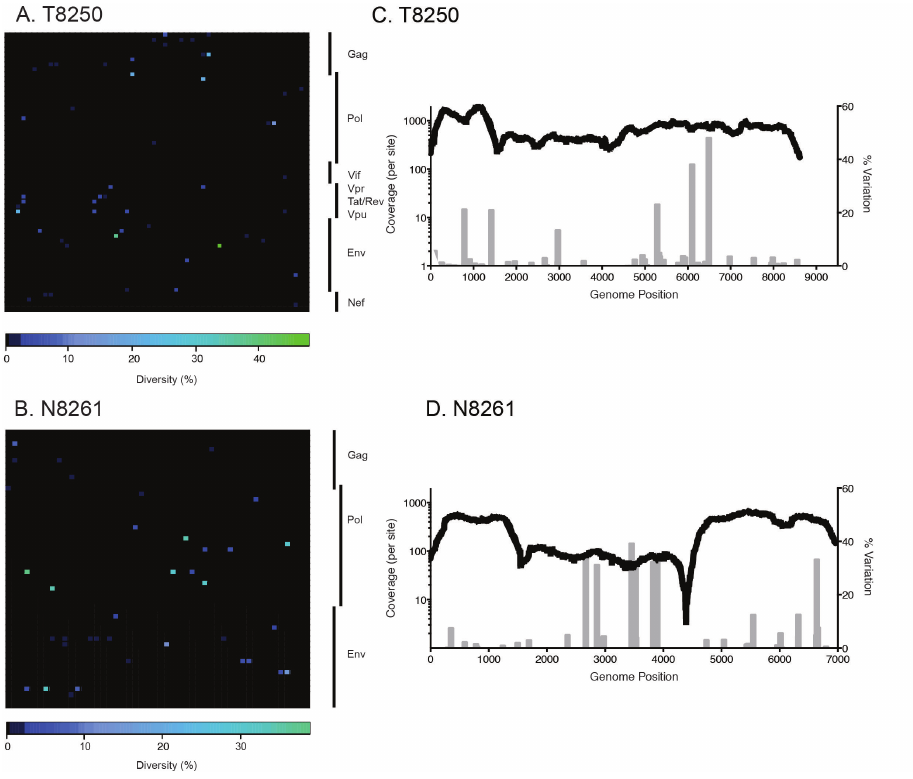
Figure 4. 454 deep sequencing of TF HIV-1 progeny in two subjects with acute infection. Heat maps illustrate both non-synonymous and synonymous codon sequence diversity of HIV-1 from DBS RNA in subjects T8250 (A) and N8261 (B). The plots are a graphical representation of the frequency of the intra-host sequence diversity with respect to the dominant codon residue (% diversity) for each codon (x-axis) of individual canonical HIV-1 proteins (y-axis). Each square represent a single codon, colored to reflect the percentage of reads that differ from the consensus residue. The diversity scale is color-coded with completely conserved residues in black and marine-blue tones for low-frequency polymorphisms in codons (< 10%), sky-blue tones for those with moderately high frequency (10–30%) and green for high frequency polymorphisms (> 30%). The entire HIV-1 proteome of subject T8250 is represented in the up- per plot, whereas the pol , gag , and env proteins are depicted for patient N8261 in the lower plot. Coverage plots depicting the coverage (sequencing reads per site, black line) and the level of variation (gray bars) at a given codon across the sequenced region of the genome are shown for subjects T8250 (C) and N8261